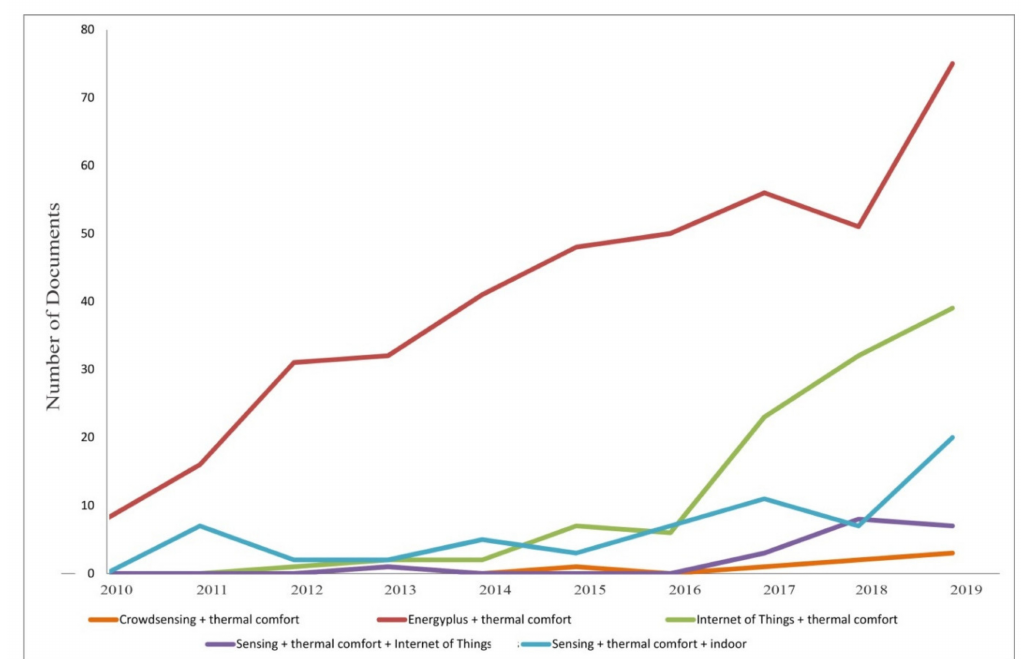
Figure 4. Trends of studies according to Scopus in the last decade. Queries: “Crowdsensing + thermal comfort”, “EnergyPlus + thermal comfort”, “Internet of things + thermal comfort”, “sensing + thermal comfort + Internet of Things” and “sensing + thermal comfort + indoor”.